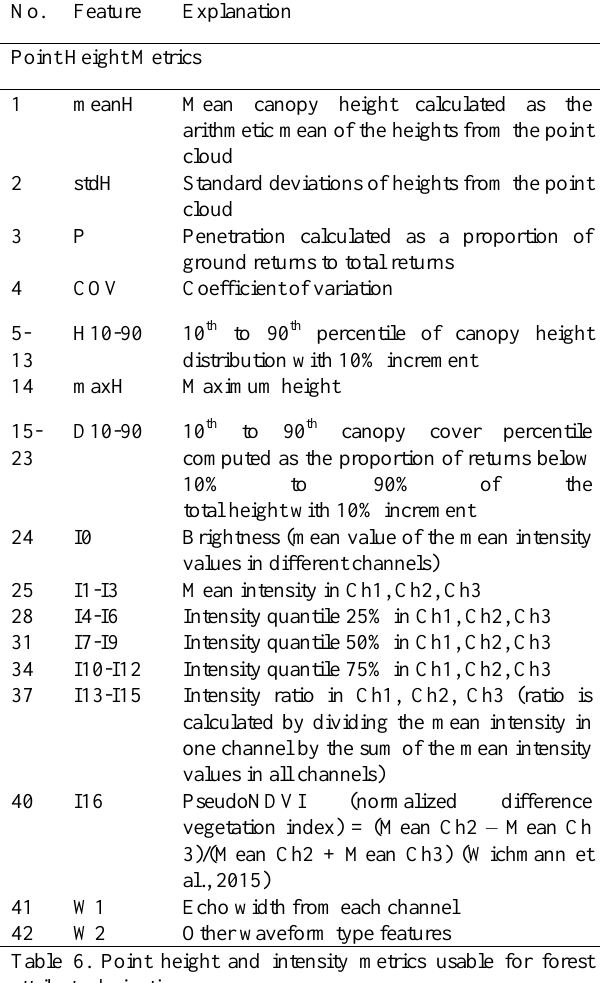
Table 6. Point height and intensity metrics usable for forest attribute